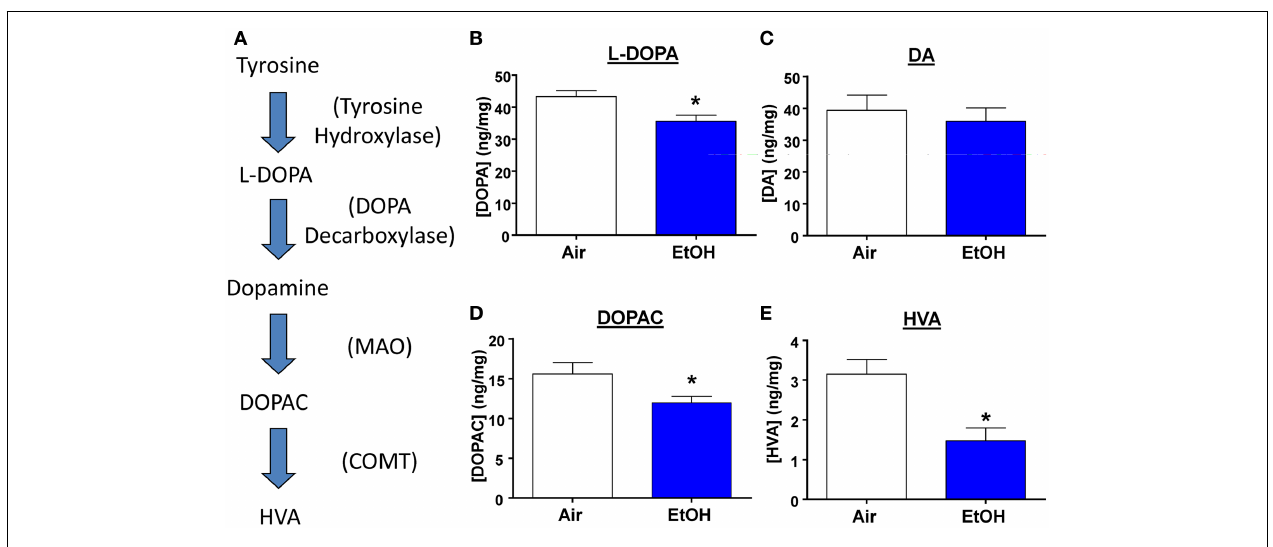
by unpaired t -test). EtOH exposure also significantly reduced levels of (D) DOPAC (* p < 0.05 by Mann–Whitney test), and (E) HVA (* p < 0.05 by Mann–Whitney test). N = 8 animals from 4 Air and 4 EtOH litters.